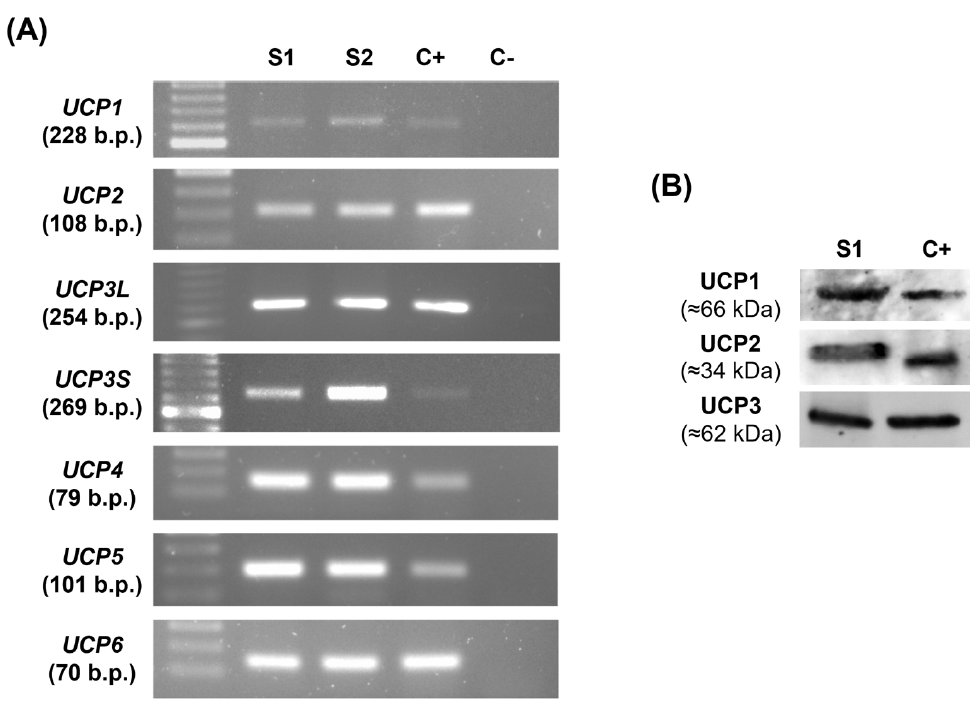
Figure 2. Identification of mitochondrial uncoupling proteins (UCPs) homologs (UCP1-6) mRNA and protein (UCP1-3) expression in human spermatozoa. ( A ) Representative RT-PCR of UCP1 , UCP2 , UCP3L , UCP3S , UCP4 , UCP5 , and UCP6 mRNA expression in human spermatozoa. Samples from two different individuals (S1 and S2) were used and cDNA from human peripheral blood leukocytes (C+) was used as a positive control. ( B ) Representative blots of UCP1, UCP2, and UCP3 protein expression in human spermatozoa (S1). Mouse kidney was used as a positive control (C+).